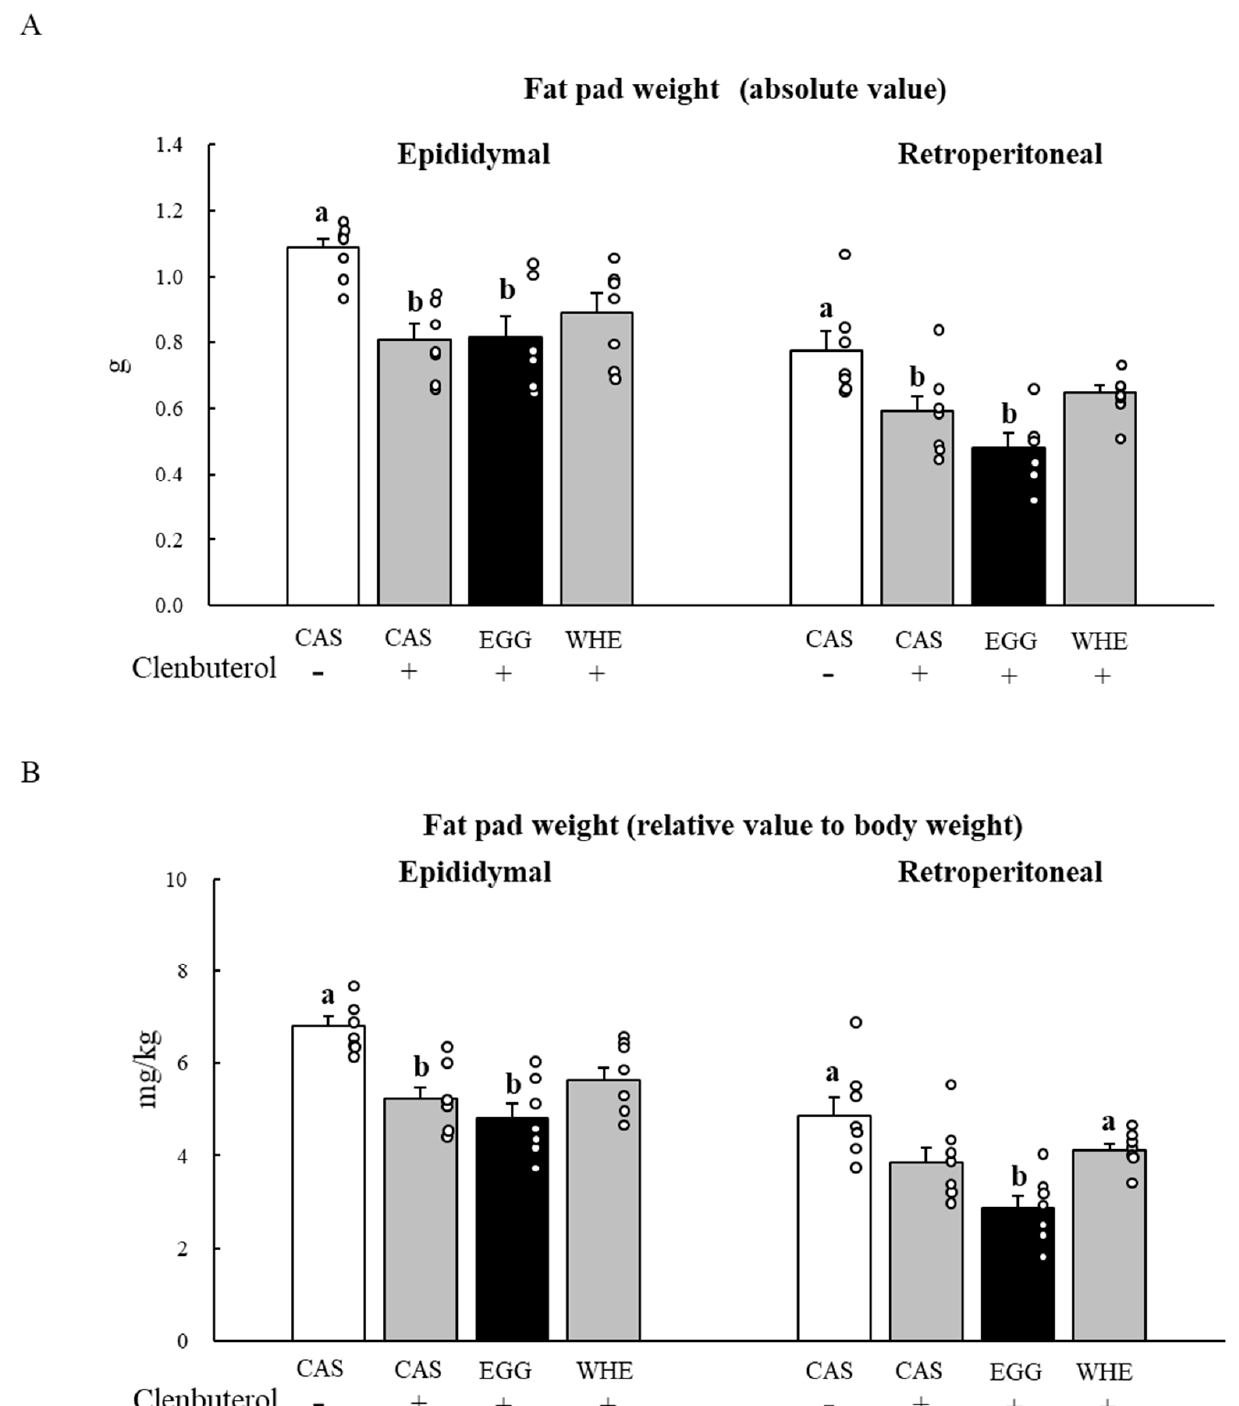
Figure 11. Chronic effect of each protein feeding on fat pad weight (Day 7). Rats were assigned to either a casein, egg white, or whey protein diet group, and were maintained under ad libitum feeding for 7 days with or without clenbuterol administration. On day 7, rats were fasted for 6 h, and then fat pads were dissected out. An absolute value ( A ) and a relative value to body weight ( B ) were calculated. The dots beside bars indicate individual value. Values are means ± SE ( n = 7). CAS: casein protein, EGG: egg white protein, WHE: whey protein. Different superscript represents statistical difference among groups in same fad pad ( p < 0.05).